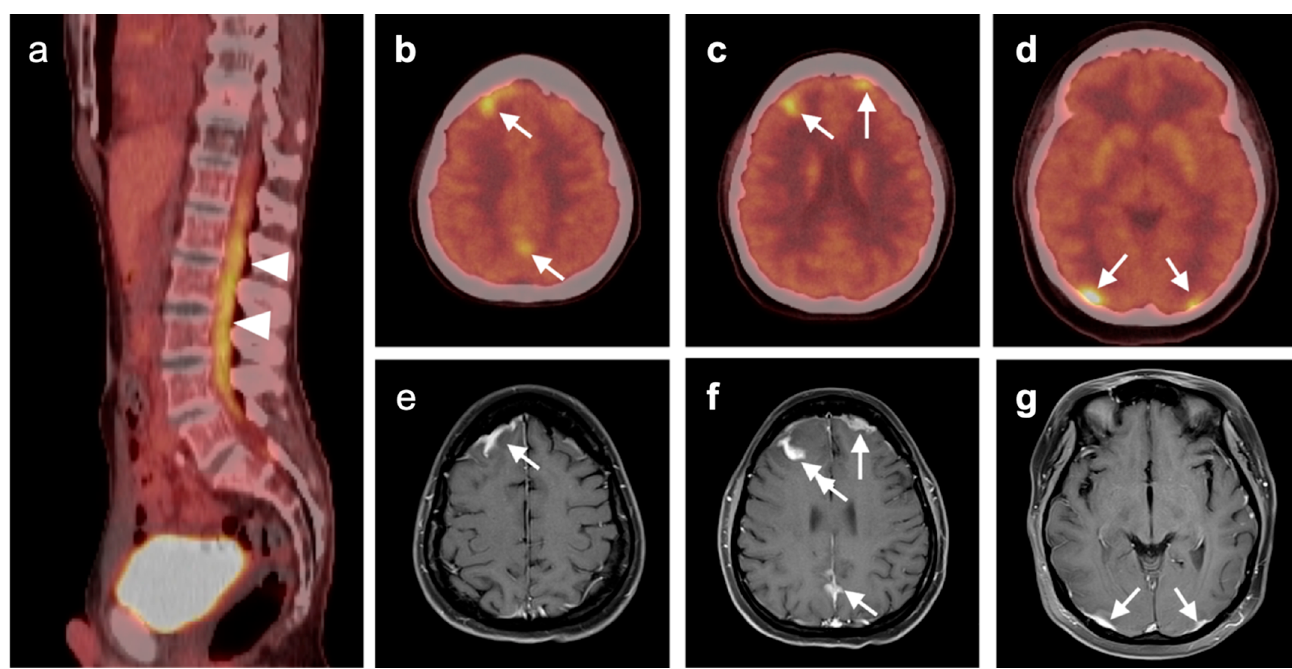
Figure 46. Leptomeningeal carcinomatosis (breast cancer). ( a ) Sagittal FDG PET-CT shows hyper- metabolism within the spinal canal due to leptomeningeal disease (white arrowheads); ( b – d ) Axial FDG PET-CT images show intense focal areas of increased metabolic activity are noted over the convexities of the brain (white arrows). ( e – g ) Axial Gd+ FST1 MRI images show intense enhance- ment at the sites of increased metabolic activity (white arrows) over the convexities, confirming leptomeningeal carcinomatosis.